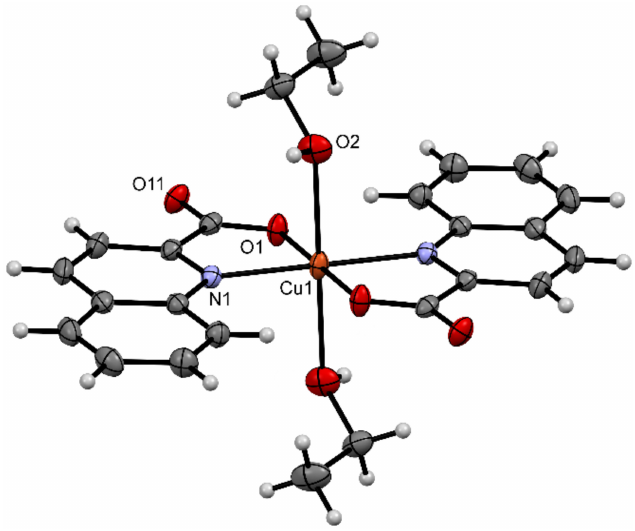
Figure 1. ORTEP drawing of trans -[Cu(quin) 2 (EtOH) 2 ] ( 1 ). Displacement ellipsoids are drawn at the 50% probability level. Hydrogen atoms are shown as spheres of arbitrary